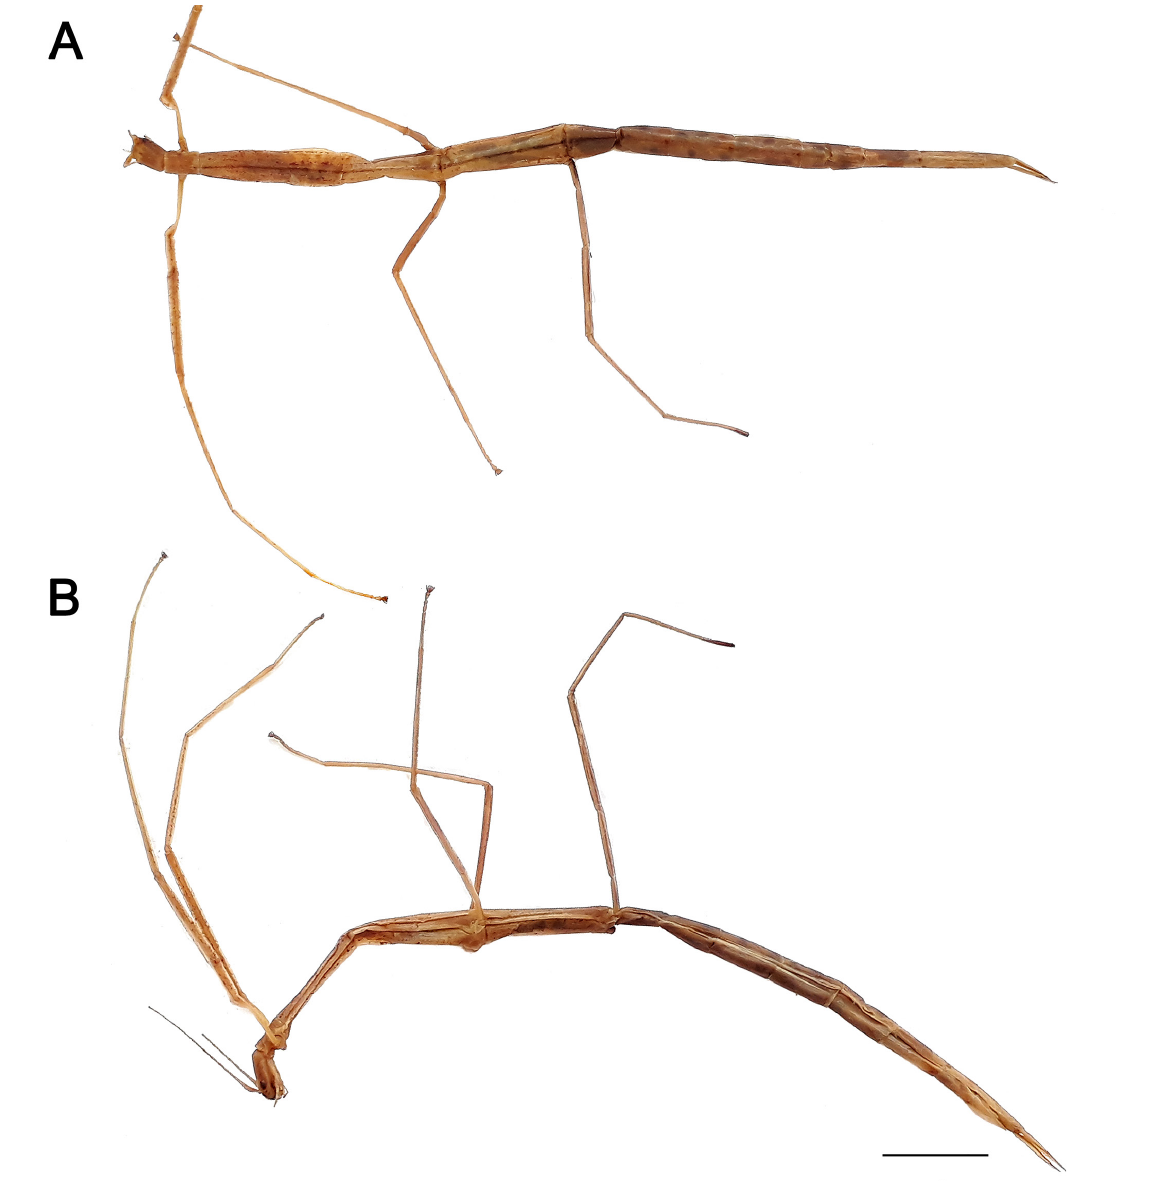
Fig. 25. Arumatia aramatia Ghirotto gen. et sp. nov., holotype, ♀ (MZUSP 1352). A . Dorsal view. B . Lateral view. Scale bar: 10